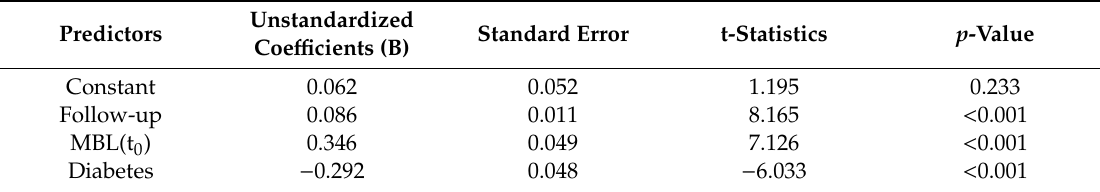
Table 7. Multivariate linear regression analysis with MBL change as the dependent variable (surgery to 5 years) and time from prosthetic delivery (follow-up), the initial vertical position of the implant (MBL(t 0 )), and the presence of type-2 diabetes (diabetes) as predictors.